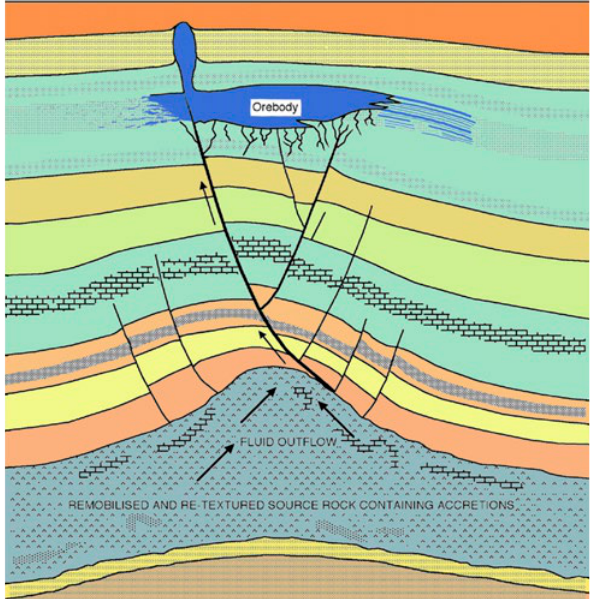
Figure 78. Diagram to indicate possible seepage paths for ore form- ing fluids from underlying source rocks.